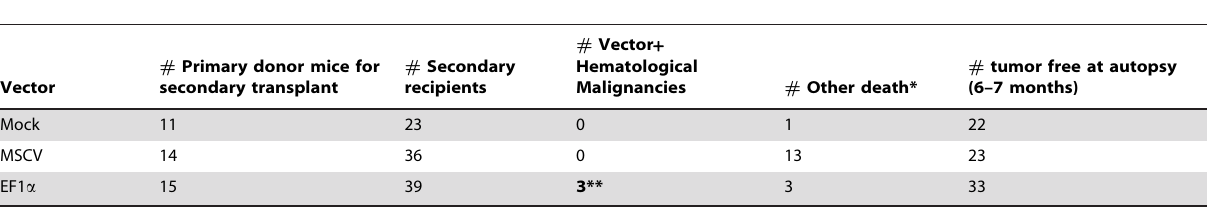
Table 2. Malignancy incidence in secondary recipient mice in Exp. 1 (donor: c C 2 / 2 , recipient: c C 2 / 2 Rag2 2 / 2 ).